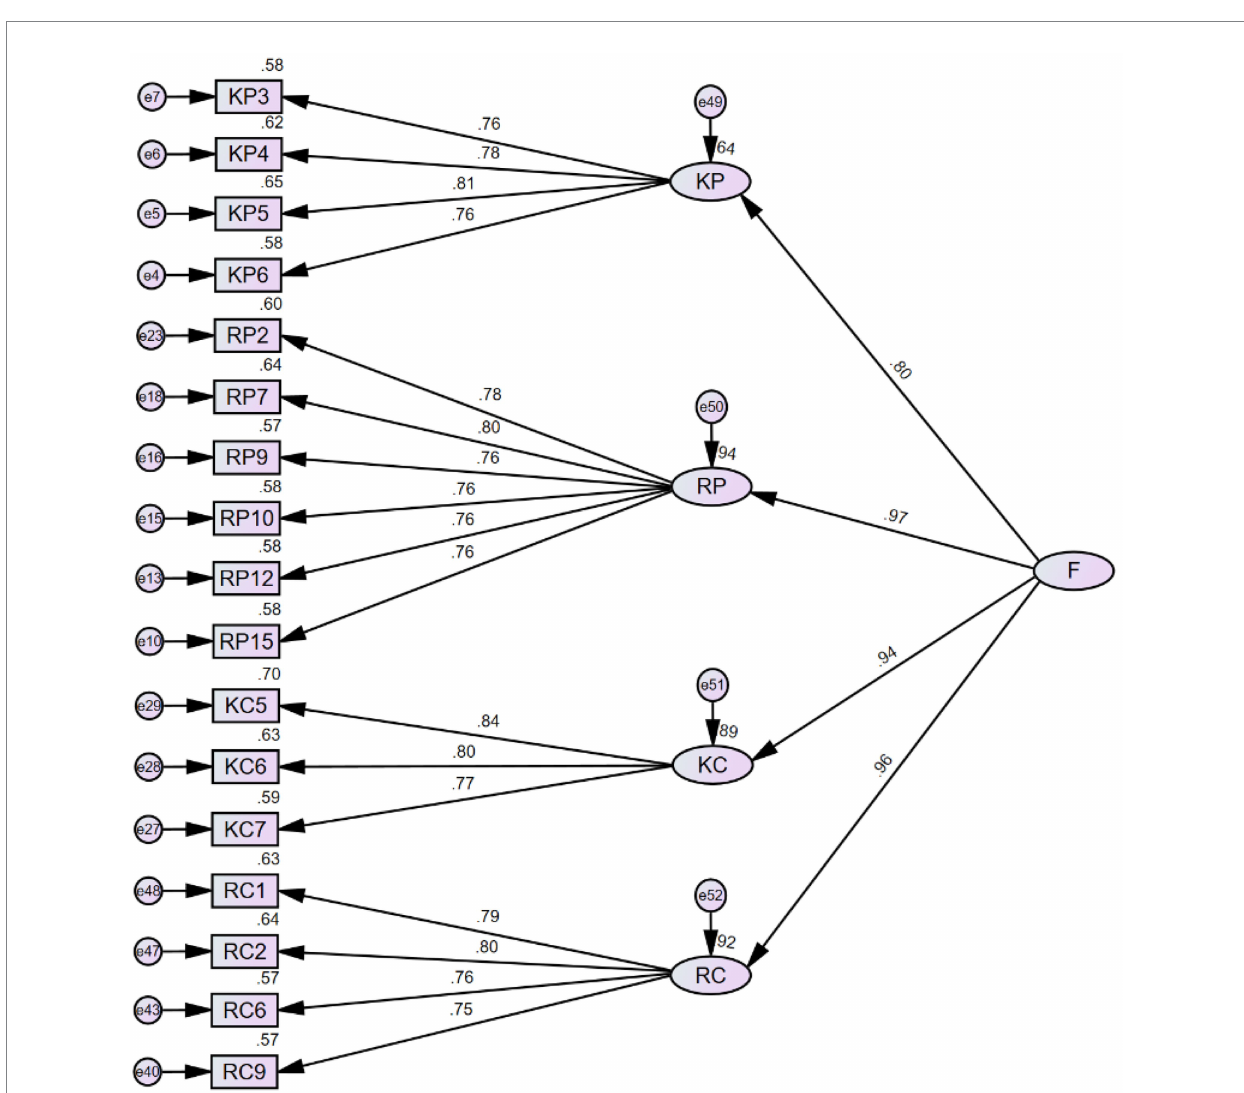
FIGURE 6 Model 6 with a single factor as the second-order factor. F stands for the single factor that we